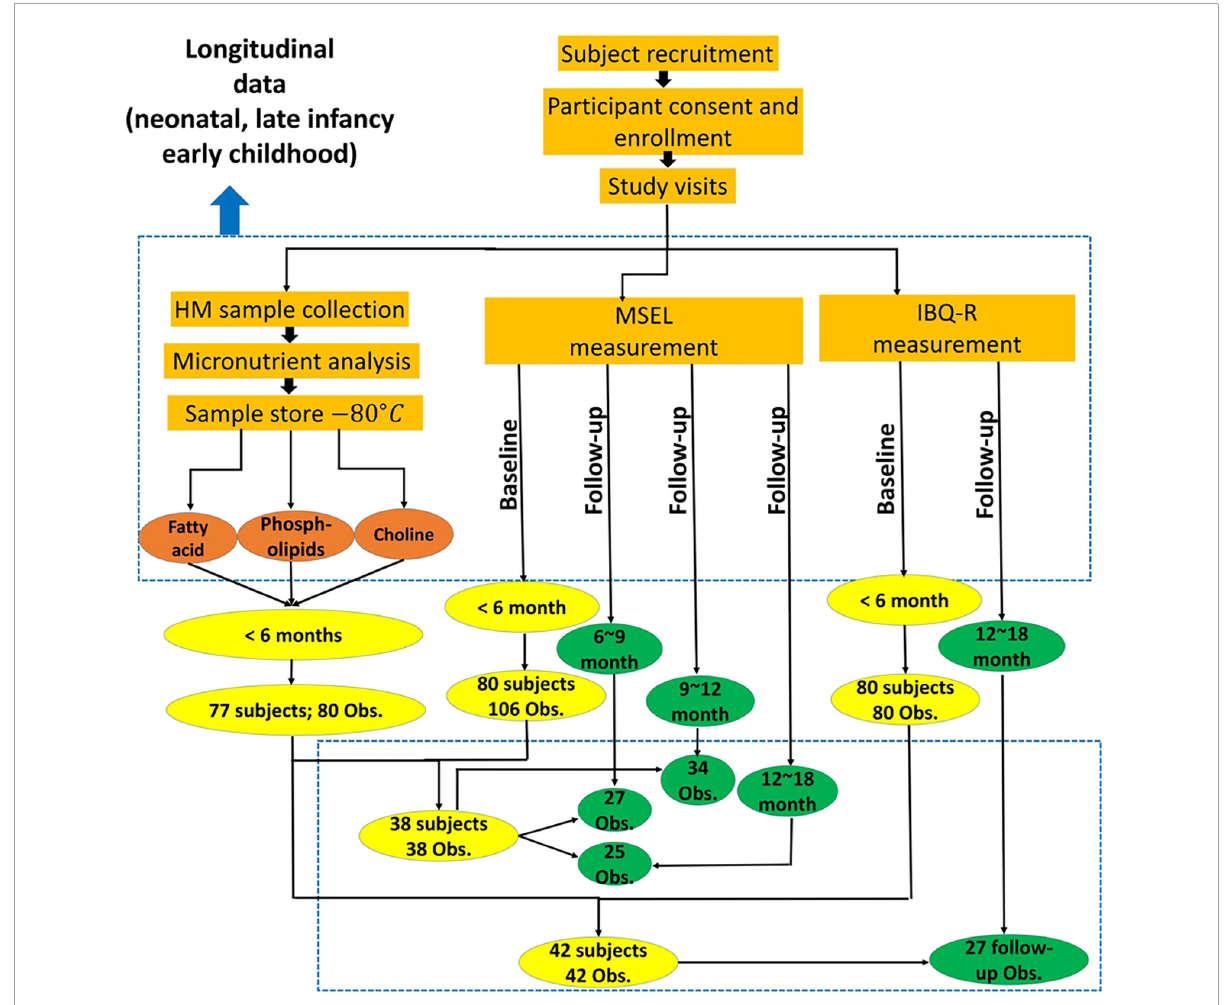
FIGURE1 Study flowchart provides the overall experimental